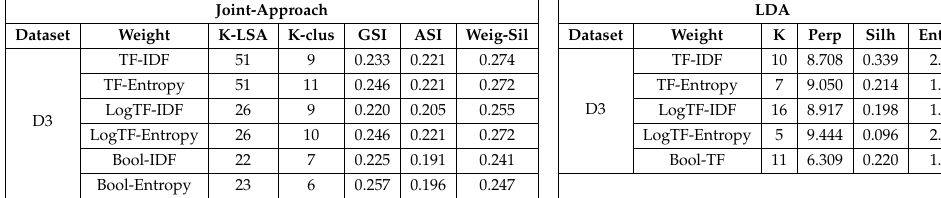
Table 7. Experimental results for D3.